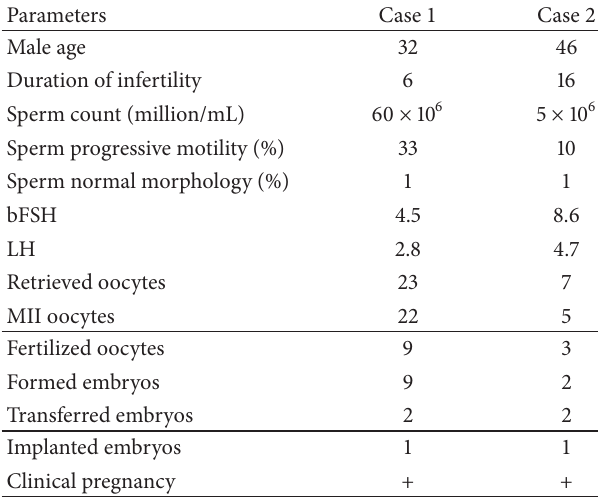
Table 1: Laboratory and clinical data for cases with